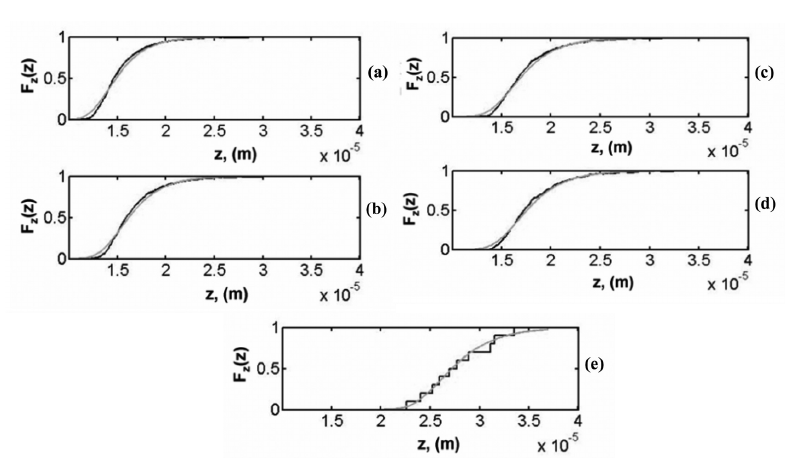
Fig. 7. Empirical CDFs of peaks for Prototype M that occur in intervals of length (a) T 1 = 1.2 seconds, (b) T 2 = 2.4 seconds, (c) T 3 = 3.6 seconds, (d) T 4 = 4.8 seconds, and (e) T 150 = 180 seconds (dark stair-step curves) plotted with the CDF of the Type I asymptotic distribution of extremes (light